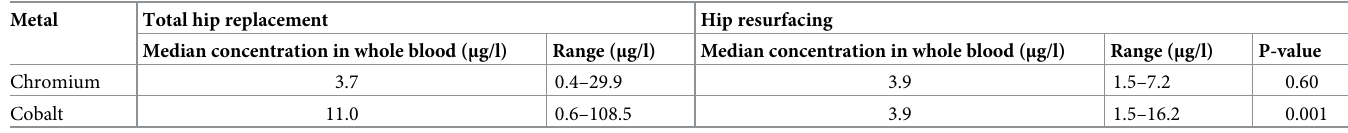
Table 3. Median values, respected p-values and ranges for whole blood metal ion concentrations in patients with unilateral total hip replacement (n = 69) or hip resurfacing (n = 13) patients. Metal Total hip replacement Hip resurfacing Median concentration in whole blood ( μ g/l) Range ( μ g/l) Median concentration in whole blood ( μ g/l) Range ( μ g/l) P-value Chromium 3.7 0.4–29.9 Cobalt